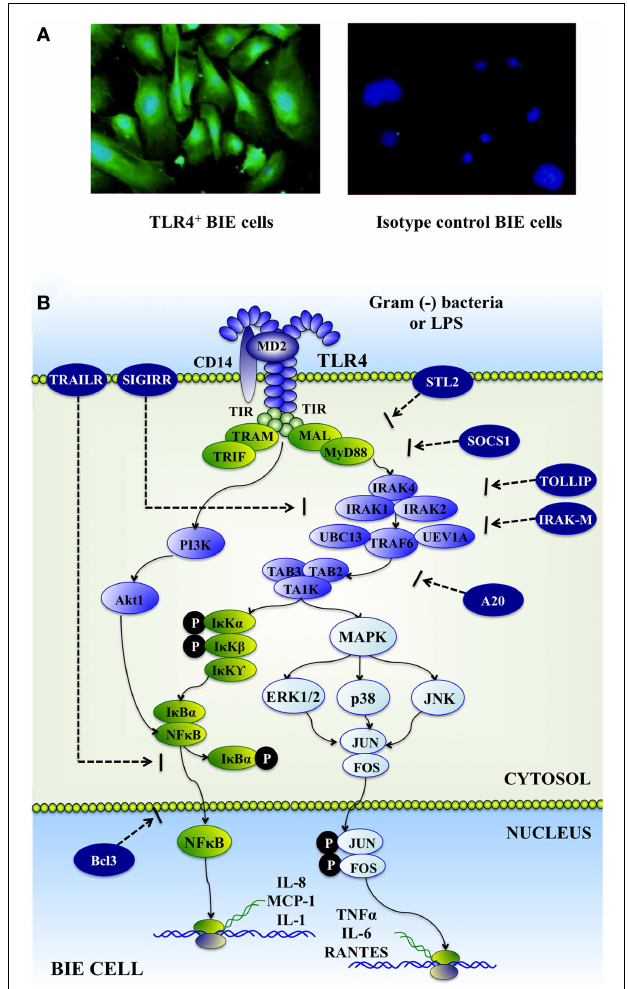
FIGURE 1 |Toll-like receptor 4 (TLR4) expression in bovine intestinal epithelial epitheliocytes (BIE cells) (A) . Upon recognition of lipopolysaccharide (LPS),TLR4 dimerizes and initiates a signaling cascades that include phosphatidylinositol 3-kinase (PI3K), mitogen-activated protein kinase (MAPK), and nuclear factor κ B (NF- κ B) pathways; and culminates in the production of inflammatory mediators by BIE cells (B)